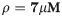
Time evolution of the uncertainty on the estimations, ρ=7μM.A priori
kon0=0.1min-1μM-1, kdep0=0.1min-1, kdis0=0.1min-1, θ0 = 0.1, observation covariance W = 10, predicted standard deviation of initial a priori estimations as in Table 2. A: 9 iterations of the Extended Kalman method black, number of the iteration in colorscale. B: Trajectories of the final estimators (red lines), the final estimations (red dashed lines) and 95% prediction uncertainty intervals (red areas). From the left to the right estimators of kon, kdep, kdis and θ.